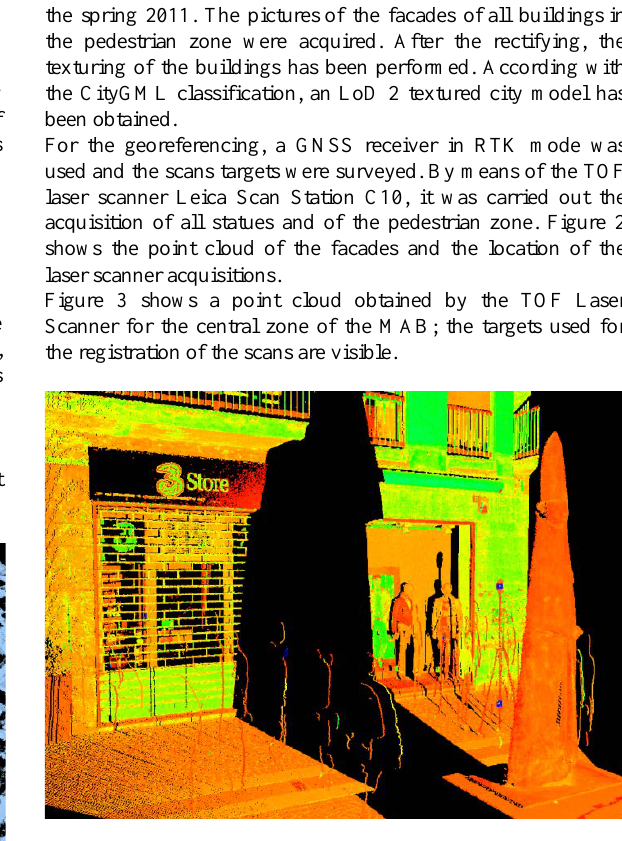
Figure 3. A point cloud obtained by the TOF Laser Scanner.